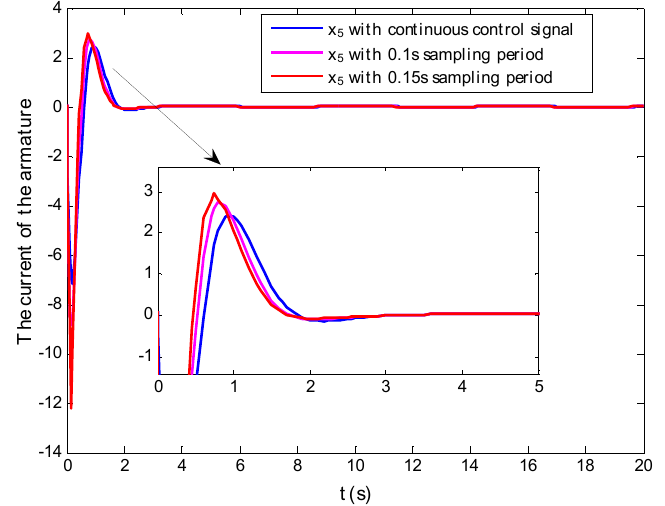
Figure 6. The trajectories of state x 5 with different sampling periods.